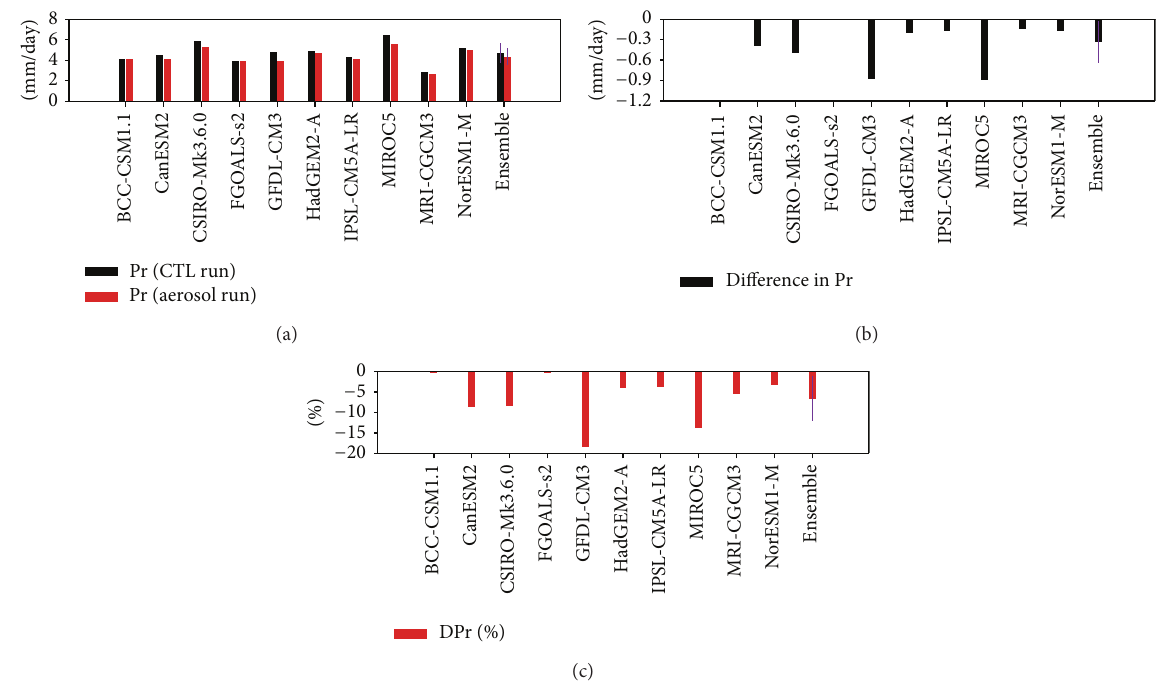
Figure 2: (a) Summer precipitation of the aerosol run (red bars) and CTL run (black bars) for each model over East China. (b) Same as (a), except for the precipitation difference between the aerosol run and CTL run (aerosol minus CTL). (c) Ratio of precipitation differences in (b) to the CTL run in each model. The far right bar and purple line in each panel are the ensemble mean and standard deviation from all simulations,